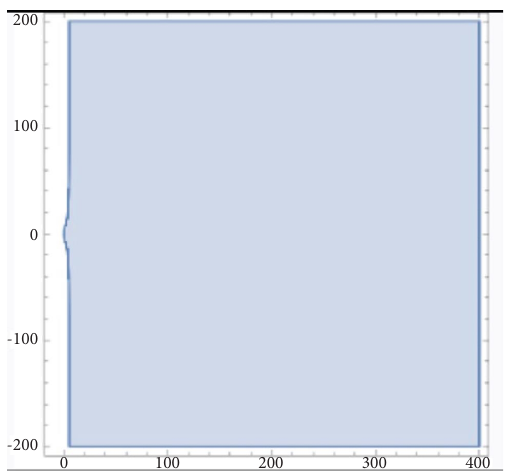
Figure 1: Stability region of the proposed